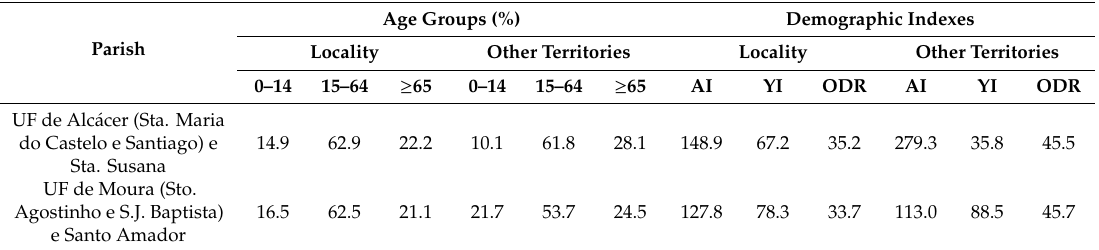
Table 10. Age groups (%) and demographic indices in localities with the municipal headquarters, and other territories belonging to APU (TIPAU) and Code 2 (DEGURBA) parishes.